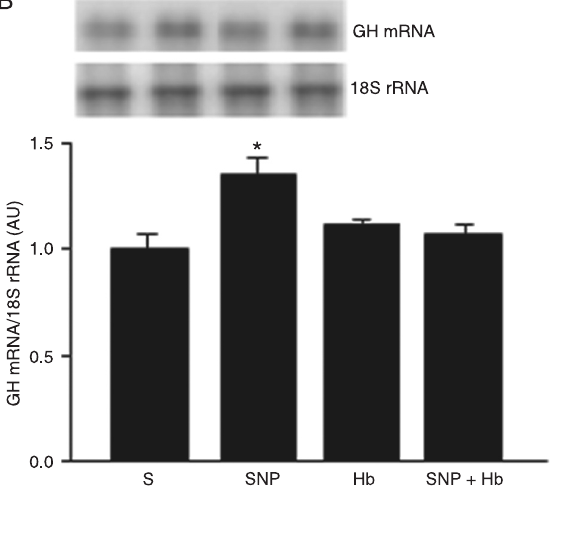
Figure 4. Effect of nitric oxide on growth hormone (GH) gene expression. Panel A , Hemi-pituitaries incubated for 1 h with sa- line (S) or sodium nitroprusside (SNP) at the following concentra- tions: 10 nM, 1 µM, 0.1 mM, and 1 mM. Panel B, Hemi-pituitaries were incubated for 1 h with S or 0.1 mM SNP in the presence or absence of 0.3 µM hemoglobin (Hb and SNP+Hb). Panel C , Hemi-pituitaries incubated for 1 h with S or 8-Br-cGMP at the con- centrations of 0.1 and 1 mM. Typical autoradiograms of the GH mRNA and 18S abundance obtained in one experiment of a total of three are shown at the top of each panel, and the quantitative representation of hybridization of GH and 18S rRNA transcripts obtained in all experiments is shown at the bottom of each panel. The values obtained from blot densitometry were normalized by 18S rRNA. Data are reported as means ± SEM in arbitrary units (AU). A , *P < 0.05 vs S, 0.1 mM SNP and 1 mM SNP; B , *P < 0.05 vs all other groups; C , *P < 0.05 vs all other groups (one-way ANOVA followed by the Student-Newman-Keuls